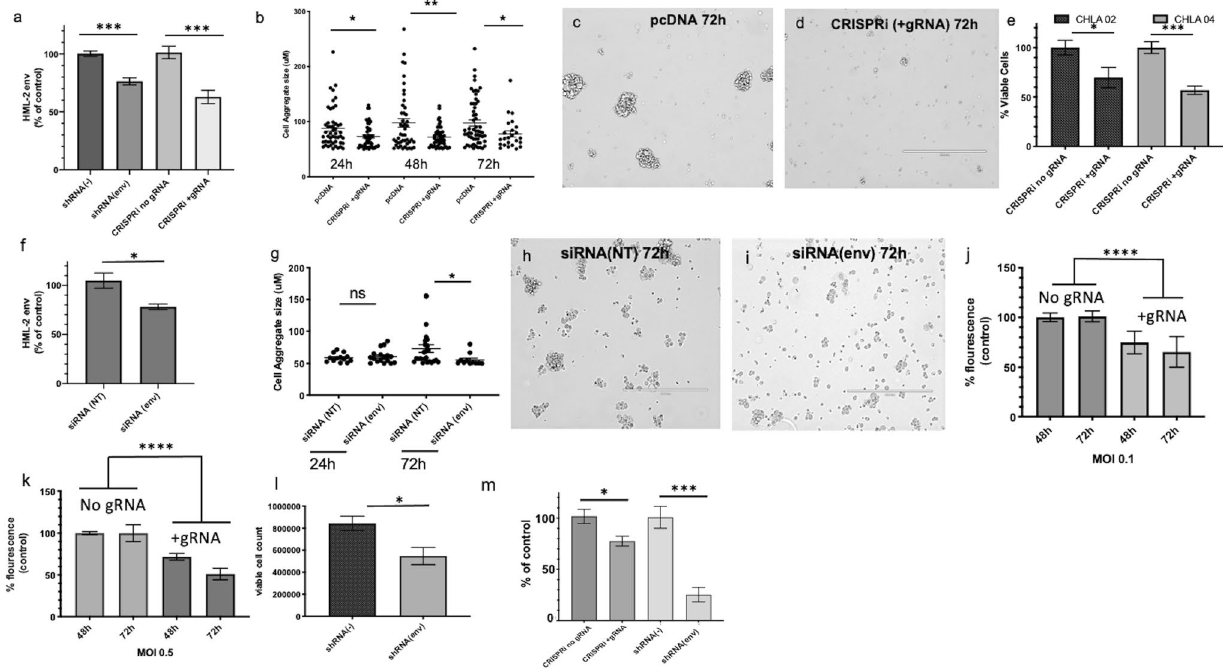
Figure 5. Effect of the Downregulation of HML-2 on AT/RT. ( a – d ) A decrease in HML-2 expression leads to reduced cellular aggregates in CHLA 02 AT/RT cells. ( a ) HML-2 env transcript levels in CHLA 02 cells 48 h post transfection with either shRNA targeting env or CRISPRi targeting HML-2 LTR. ( b ) CHLA 02 cells transfected with CRISPRi + gRNA have reduced aggregate size following reduced expression of HML-2 mRNA at 24 h, 48 h, and 72 h post transfection. ( c ) CHLA 02 cells at 72 h post transfection with either pcDNA or ( d ) with CRISPRi + gRNA. ( e – i ) Downregulation of HML-2 results in AT/RT cell death and reduced cell aggregates. ( e ) CHLA 02 and CHLA 04 cells transfected with CRISPRi with or without gRNA targeting HML-2 LTR results in different proportions of viable cells at 96 h post transfection. ( f ) Percent of control (siRNA non-targeting) env transcription following transfection with siRNA targeting HML-2 env in CHLA 02 at 24 h. ( g ) CHLA 02 cell aggregates were reduced in size after 72 h following siRNA transfection targeting HML-2 env. ( h ) CHLA 02 at 72 h post transfection with both non-targeting siRNA and ( i ) cells treated with HML-2 env siRNA. ( j – m ) Lentiviral vectors with CRISPRi + gRNA targeting HML-2 and shRNA targeting HML-2 env result in decreased AT/RT viability and a reduction in HML-2 env protein expression. ( j , k ) CHLA 02 cytotoxicity at multiple time points post-transduction with lentivirus expressing either a CRISPRi construct with CRISPRi + gRNA targeting HERV-K (HML-2) LTR5_Hs or with CRISPRi without gRNA. ( l ) Percent viable cells 48 h post-transfection shRNA targeting HML-2 env. ( m ) env protein post-transfection as a percent of control transfection (either with CRISPRi and no gRNA or shRNA (−)). Graphs generated with Prism v9. [Error bars represent SEM. Statistics in Supplemental Table S6].